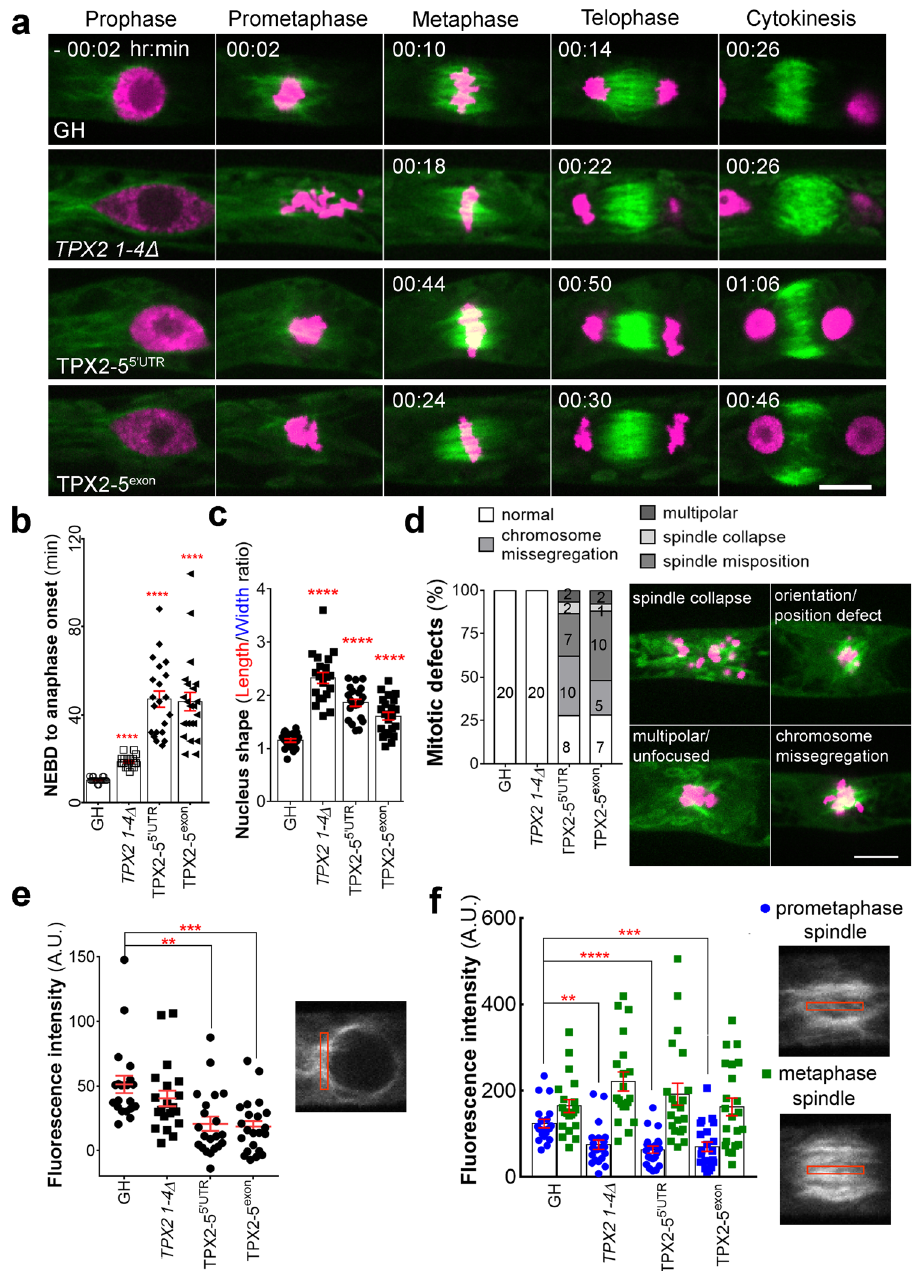
Fig. 7 TPX2 contributes to microtubule ampli fi cation in early mitosis. a Representative images of the mitosis of protonemal apical cells in GH (control), TPX2 1-4 Δ , TPX2-5 5 ’ UTR RNAi, and TPX2-5 exon RNAi lines. Time 0 (min) was set at NEBD. Green, GFP-tubulin; Magenta, histoneH2B-mRFP. Bar, 10 µ m. b Mitotic duration calculated from NEBD to anaphase onset (mean ± SEM; **** p < 0.0001, two-tailed Student ’ s t-test). Live-cell imagining was repeated three times with similar results. c Nucleus shape prior to NEBD, measured as a ratio of nucleus length to nucleus width (mean ± SEM; **** p < 0.0001, two- tailed Student ’ s t-test). d Frequency and type of mitotic defects observed. Numbers within the columns indicate number of cells with corresponding phenotypes. Bar, 10 µ m. e Fluorescence intensity of perinuclear MTs (mean ± SEM; ** p = 0.0011, *** p = 0.0002; two-tailed Student ’ s t-test). A.U. stands for Arbitrary Units. f Fluorescence intensity of MTs in the prometaphase spindle (4 min after NEBD) and metaphase spindle (2 min before anaphase onset), measured from a single focal plane, with the cytoplasmic background subtracted. A decrease in fl uorescence intensity was detected in prometaphase, but not in metaphase spindles (mean ± SEM ** p = 0.0018, **** p = 0.00002, *** p = 0.0008; two-tailed Student ’ s t-test). For graphs b – f , number of independent cells observed n = 20 for GH and TPX2 1-4 Δ lines, n = 21 for TPX2-5 5 ’ UTR , and n = 22 for TPX2-5 exon RNAi